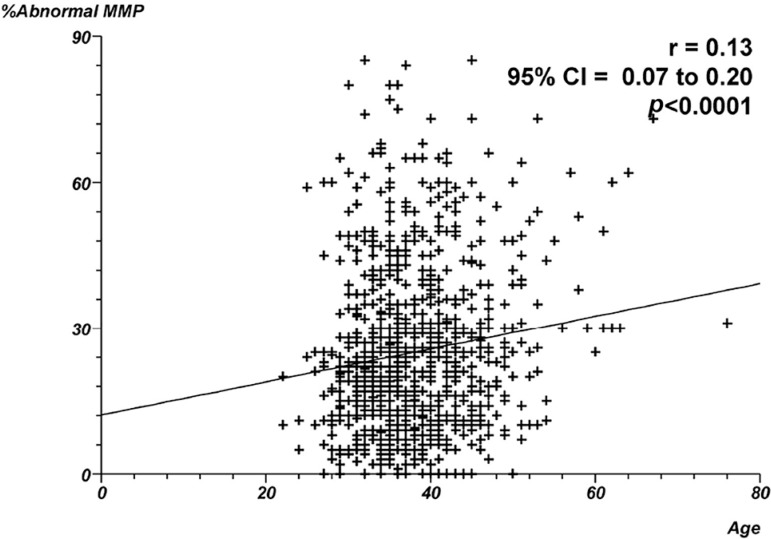
Correlation between male age and proportion of abnormal MMP.
Individual data points and the regression line are shown. Spearman's
rank correlation coefficient = 0.13;
p<0.0001.